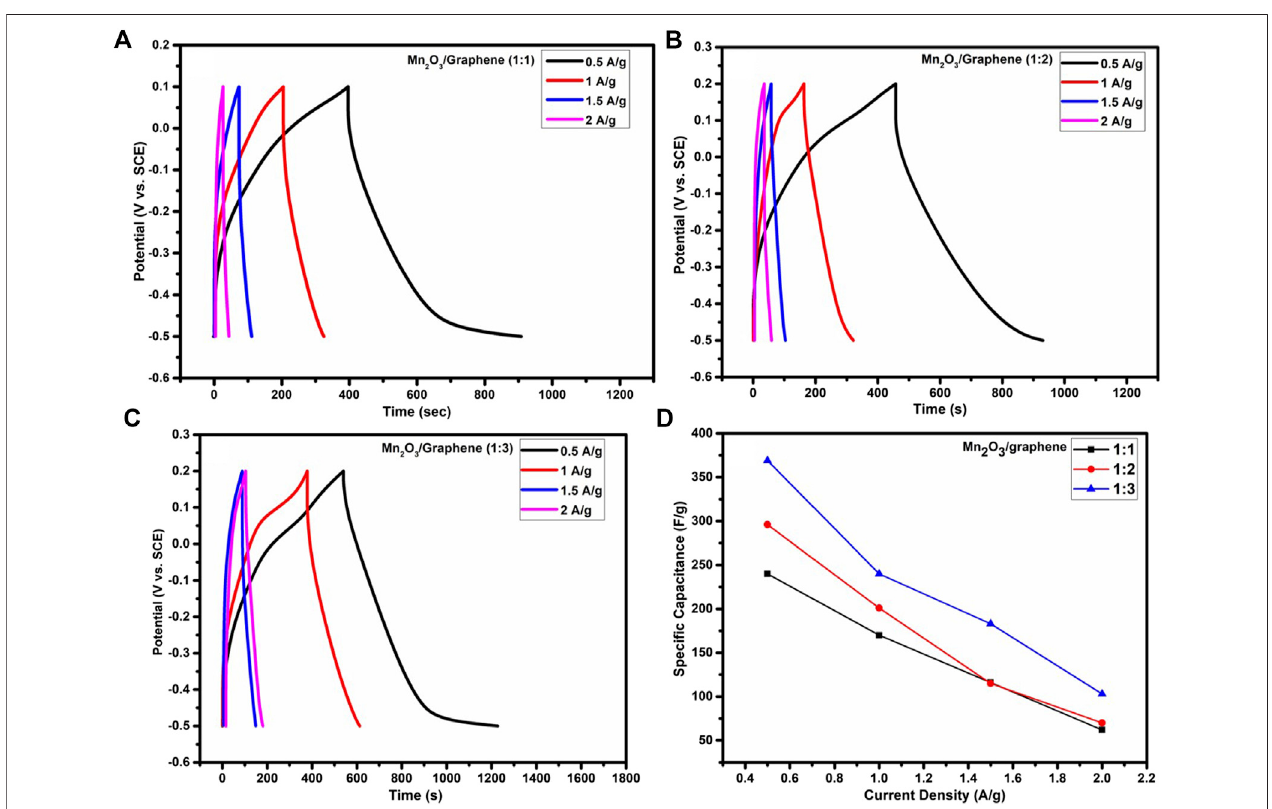
FIGURE 5 | The Nyquist plot of electrochemical impedance spectroscopy of the Mn 2 O 3 /graphene composite material.